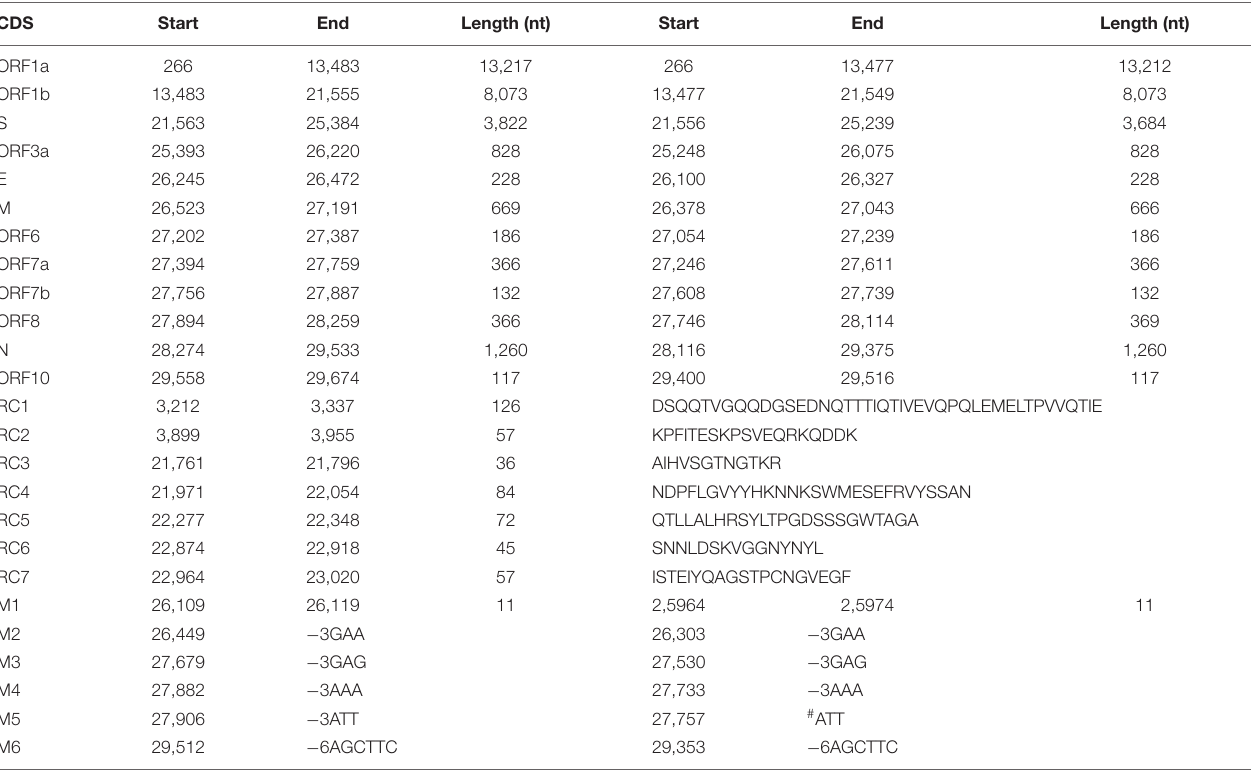
TABLE 1 | Annotations of recombination regions and mutation